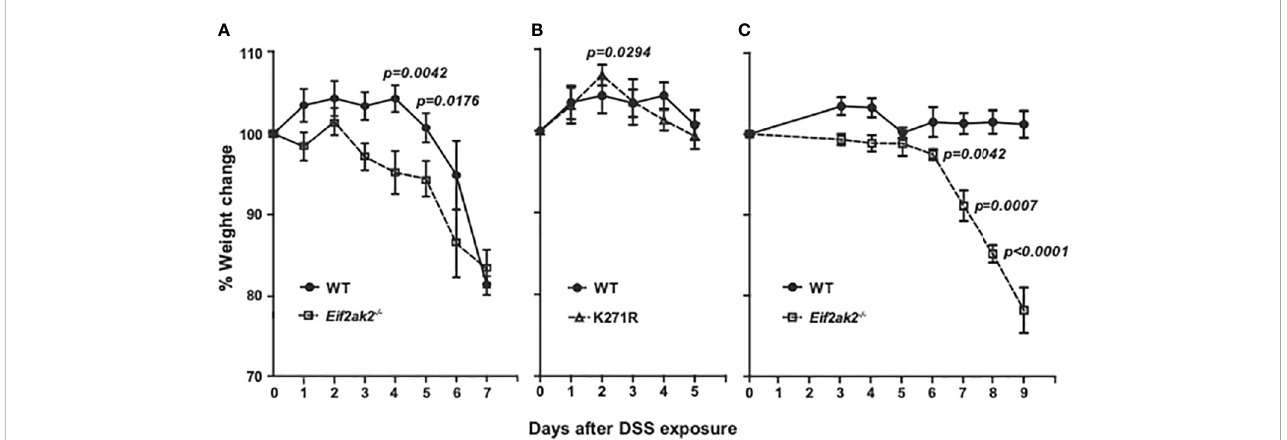
FIGURE 1 PKR reduces DSS-induced weight loss. (A – C) Body weight of mice treated with 2.5% DSS in their drinking water, expressed as the percentage change from the starting weight of: (A) Separately reared WT and PKR-ablated ( Eif2ak2 -/- ) mice (n=19 and 13, respectively); (B) WT compared to PKR kinase-dead (K271R) mice (n=19 and 7, respectively), and; (C) Cohoused WT and Eif2ak2 -/- littermates (n=5 and 3, respectively). Data were collected from three independent experiments and are expressed as the mean ± S.E.M. and analyzed by two-way ANOVA with S ̌ idàk post-test on the means between genotypes on each